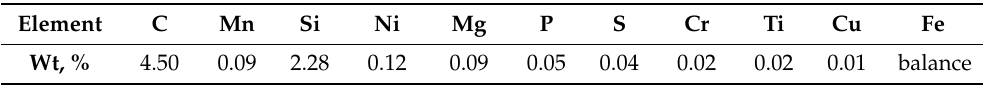
Figure 1. Low-pressure single channel centrifugal pump: ( a ) rotor; ( b ) the corroded and worn area of the rotor. Table 1. The chemical composition of cast iron which is used for dynamic constructive components of submersible pump